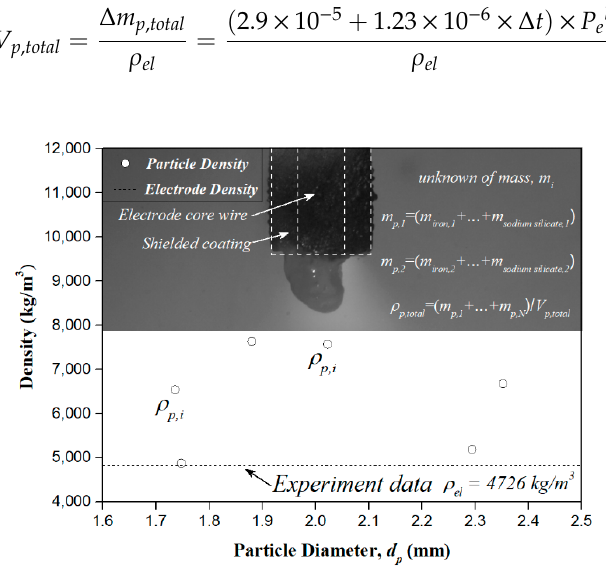
Figure 6. Measured value of one particle density using d p = 1.73–2.35 mm.